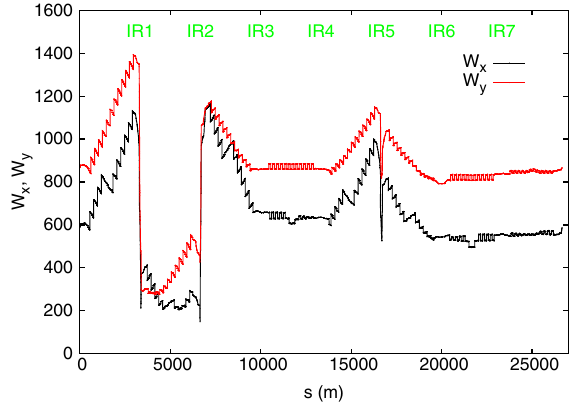
FIG. 9. Montague W x and W y functions after the LHC-like chromatic correction along beam 2 (the machine starts in IP8).